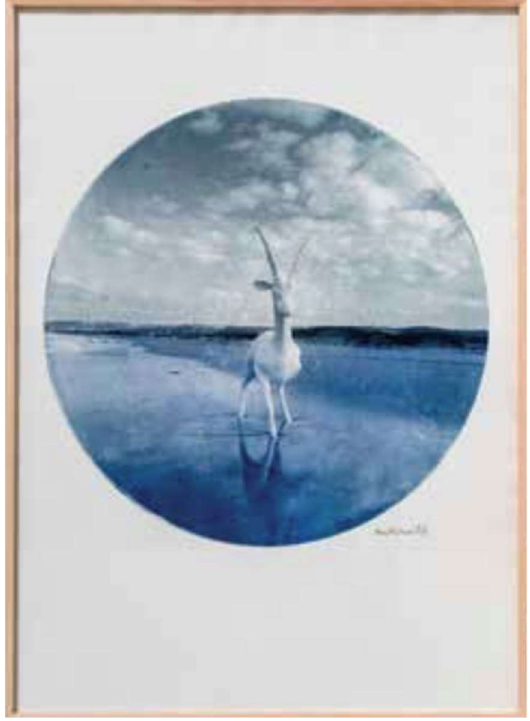
Figure 6. Manal Mahamid, Haifa Sea (2017), mixed media, 60 × 82 cm.